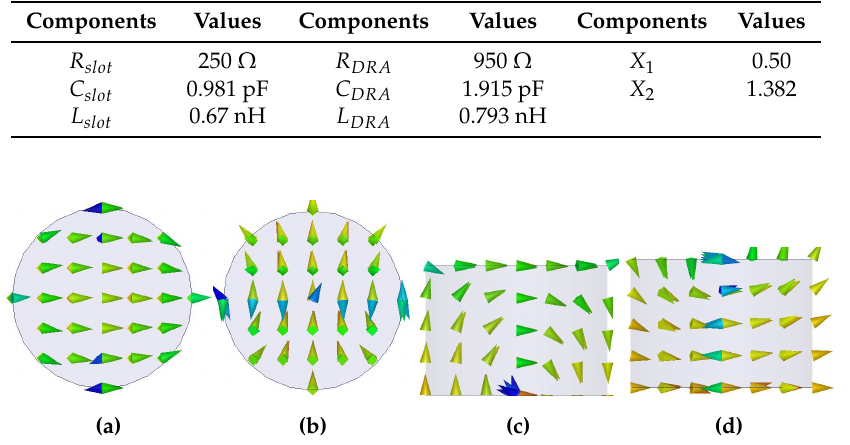
Figure 4. E-fields and H-fields distribution on DRA ( a ) Top view: E-fields ( b ) Top view: H-fields ( c ) Side view: E-fields ( d ) Side view: